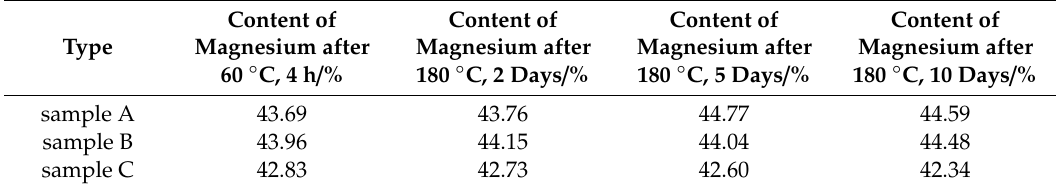
Figure 12. Change trend of the active magnesium content of the ignition composition of Mg/TeO 2 after the storage test at 180 °C. Table 3. Change data of the active magnesium content in the ignition composition of Mg / TeO 2 according to storage test days at 180 °C.